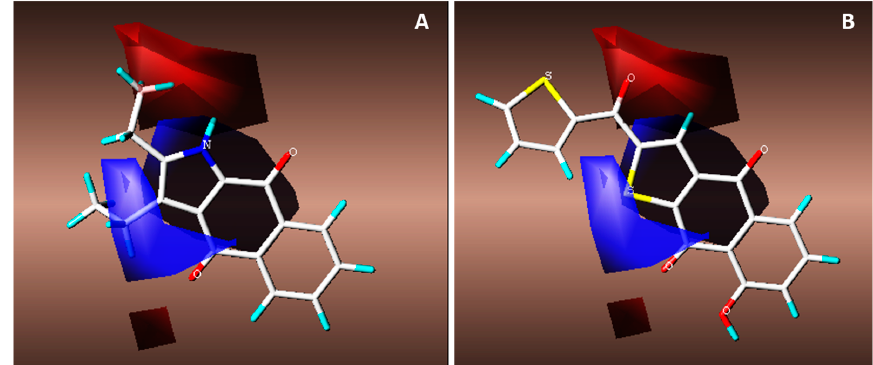
Figure 4. Electrostatic contour maps generated by comparative molecular field analysis (CoMFA) for: ( A ) 2,3-diethyl-1 H -benzo[ f ]indole-4,9-dione ( 2d ), the least active compound of the series; and ( B ) hydroxy-2-(thiophen-2-ylcarbonyl)naphtho[2,3- b ]thiophene-4,9-dione ( 7 ), the most active.